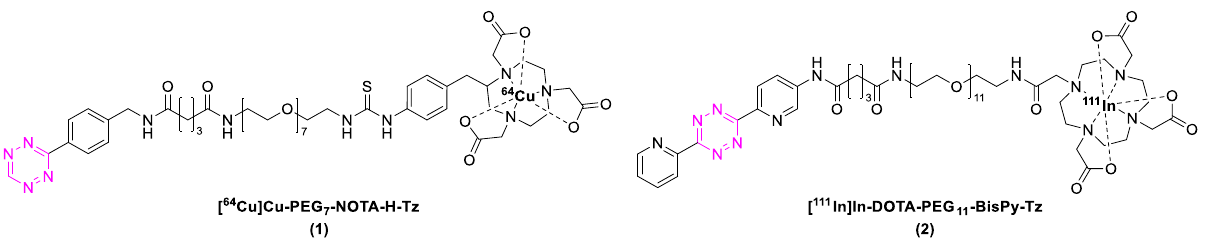
Figure 1 . The chemical structures of [ 64 Cu]Cu-NOTA-PEG 7 -H-Tz ( 1 ) and [ 111 In]In-DOTA-PEG 11 -BisPy-Tz ( 2 ).